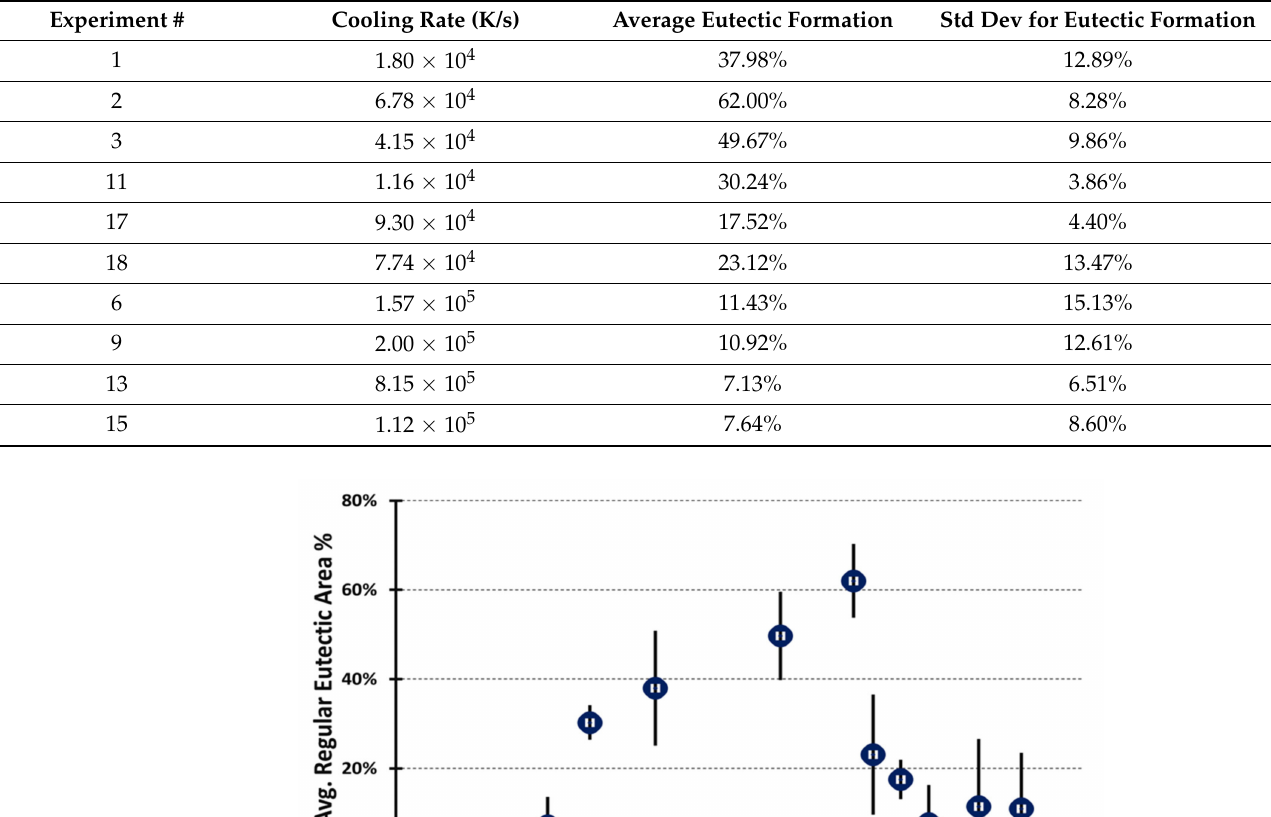
Table 2. Cooling rates for the highest and lowest eutectic volume fractions.